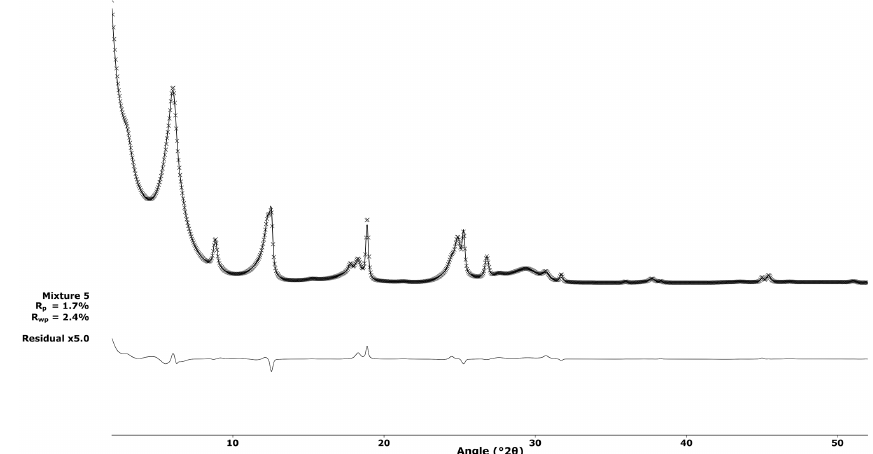
Figure 5. Calculated patterns for mixture 5 for PyXRD (solid line) and Sybilla (crosses). For clarity the residual pattern is scaled to 5 times its original intensity.